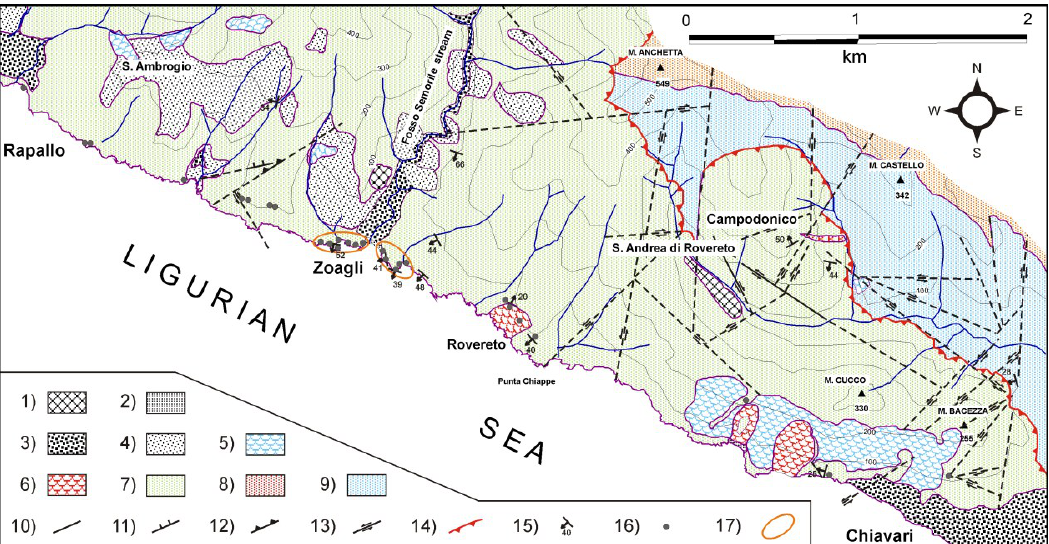
Fig. 2 Fig. 2. Geological sketch of the study area (Elter et al., 2005; modified): (1) embankments; (2) beach deposits; (3) alluvial deposits; (4) eluvium/colluvium; (5) landslides in detrital deposits (dormant); (6) landslides in detrital deposits (active); (7) Mt. Antola Flysch; (8) Manganesiferi Shales; (9) Palombini Shales; (10) faults; (11) normal faults; (12) reverse faults; (13) transcurrent faults; (14) thrusts; (15) attitude of the bedding planes; (16) survey stations; (17) test